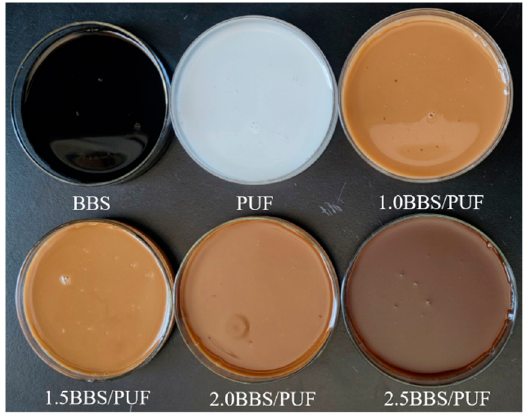
Figure 1. The appearance of BBS, PUF, and BBS modified PUF resins with different additions. BBS: